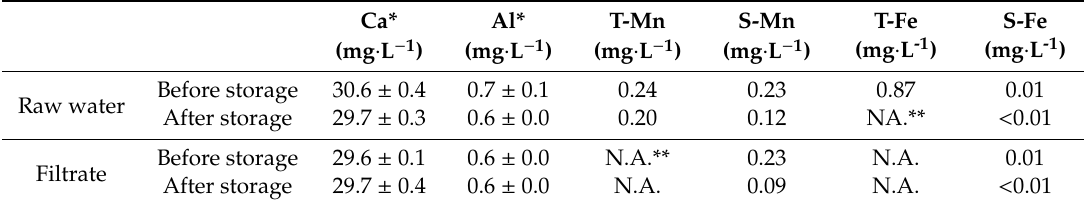
Table 3. Inorganic contents in raw water and filtrate (November